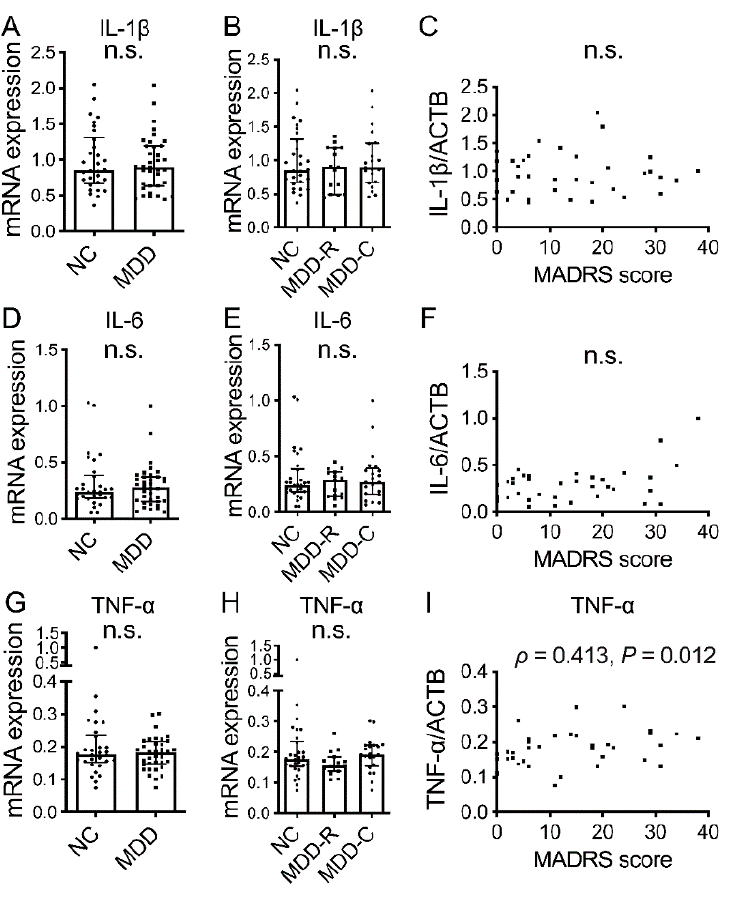
Figure 1. Blood mRNA for inflammatory cytokines in MDD and NC. Blood mRNA levels for IL-1 β ( A ), IL-6 ( D ) and TNF- α ( G ) in NC group and MDD group overall. Blood mRNA levels for IL-1 β ( B ), IL-6 ( E ) and TNF- α ( H ) in NC group, MDD remission group (MDD-R) and current MDD group (MDD-C). Horizontal lines indicate medians and error bars (IQR). Correlations of MADRS score with blood IL-1 β mRNA ( C ), IL-6 mRNA ( F ) and TNF- α mRNA ( I ). n.s.: not significant.